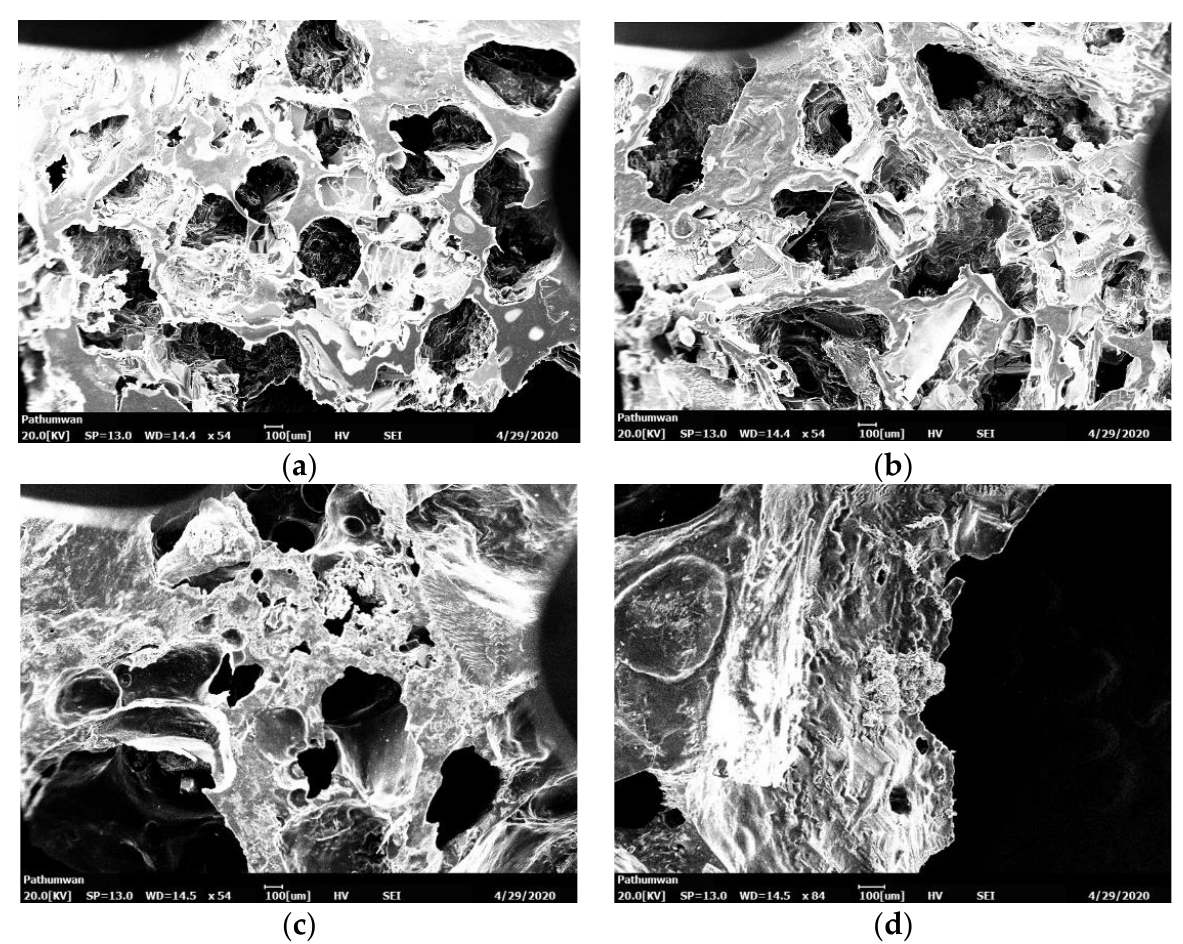
Figure 6. SEM images of the scaffold obtained via the salt-leaching technique with gelatin/Na 2 Ti 3 O 7 mixed in a ratio of ( a ) 90/10, ( b ) 80/20, ( c ) 70/30, and ( d ) 60/40; all biomedical scaffolds underwent dehydrothermal treatment for 48 h.